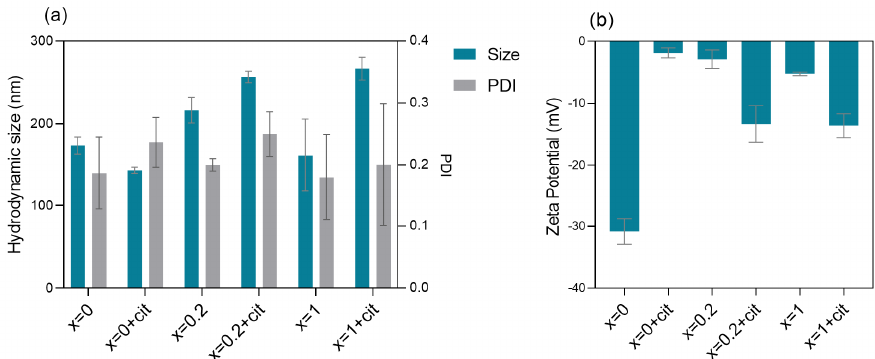
Figure 3. Hydrodynamic size, PDI value ( a ) and zeta potential ( b ) of the bare and citrate-functionalized Ca x Mn 1-x Fe 2 O 4 NPs at 0.01 mg/mL in phosphate buffer pH 7.4. Each value represents the mean ± SD (SD: standard deviation) of two or three independent measurements. Abbreviations: x = 0 + cit, x = 0.2 + cit and x = 1 + cit are citrate−functionalized MnFe 2 O 4 , Ca 0.2 Mn 0.8 Fe 2 O 4 and CaFe 2 O 4 nanoparticles, respectively.